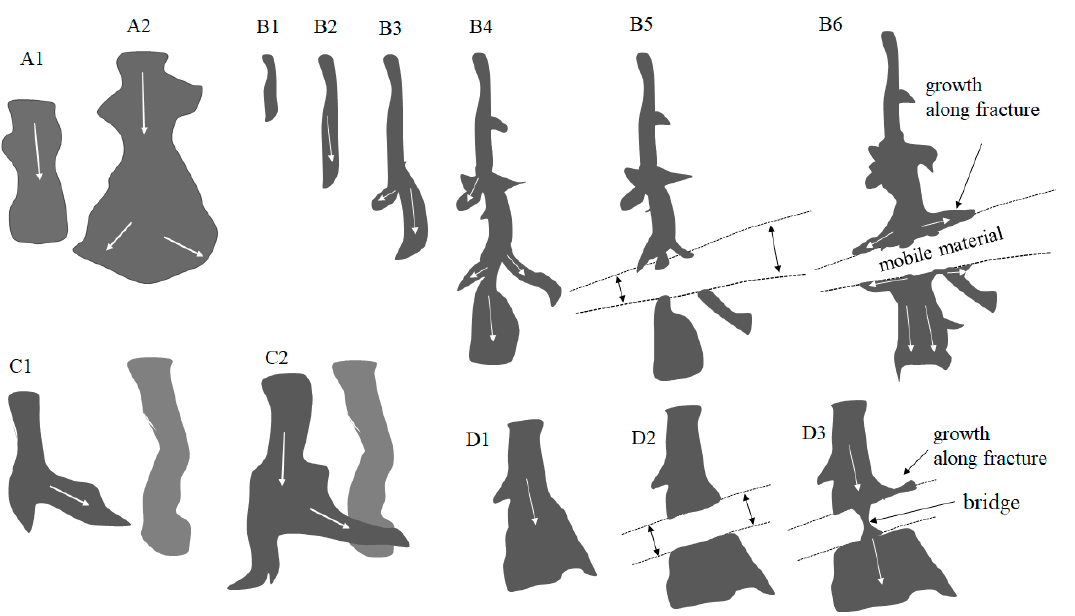
Figure 16. The four suggested patterns as deduced from images that indicate dendritic growth from the stem to the branches. ( A1 , A2 ) Dendrite increasing width as it grows. ( B1 – B4 ) Growth interrupted by sub-parallel faults, gap filled with mobile material, and subsequent growth of a narrow bridge between the two earlier connected portions ( B5 ), dendrites growing again following the fracture lines ( B6 ). ( C1 , C2 ) Branch superposition. ( D1 – D3 ) Faults splitting one dendrite, with the gap becoming filled with mobile material.